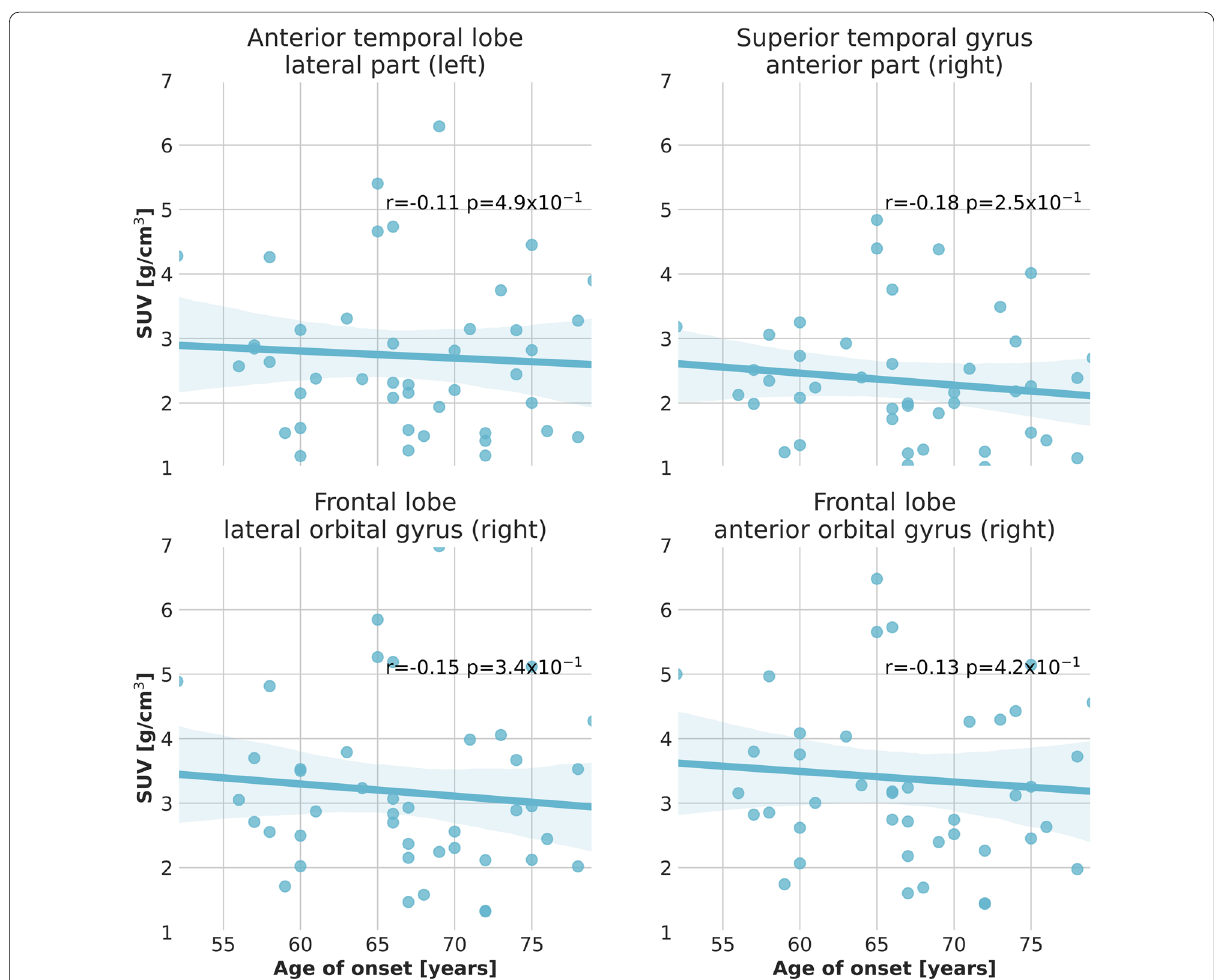
Fig. 3 Average SUV in the temporal lobe and the frontal lobe observed with [ 18 F]florbetaben PET. The average SUV of [ 18 F]florbetaben uptake does not exhibit any correlation with the age of onset of AD. A linear regression with 95% confidence bands is shown on the plots for better visualization of the